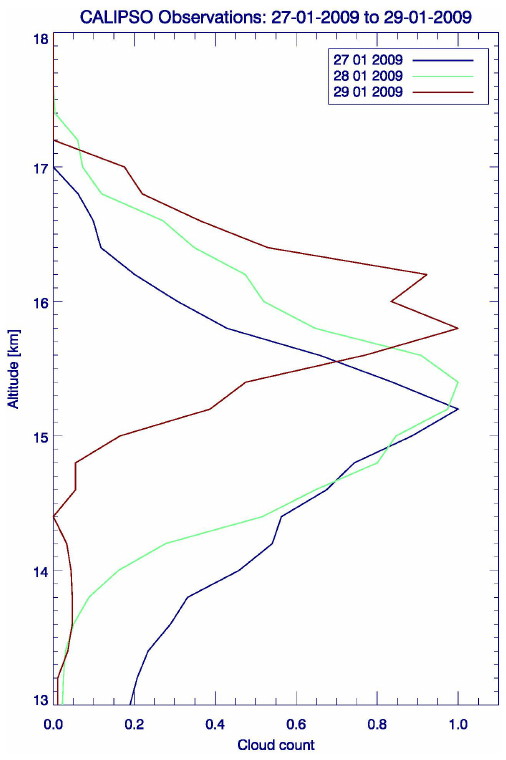
Fig. 4. Normalized distribution of cloud altitudes detected by CALIPSO in the Eastern Pacific on 27–29 January 2009. The distri- bution is determined from the CALIPSO 5km Cloud Layer product (v2.2). Between the cloud base and cloud top, a cloud is counted every 200 m for each day of observations within the cloud outline from Fig. 3. For comparison, the peak count is normalized to 1 for each day.